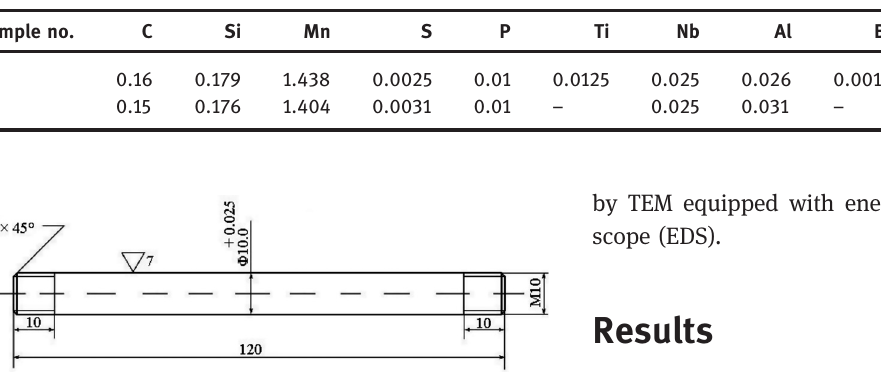
Figure 1: Shape of the hot tensile test specimen.